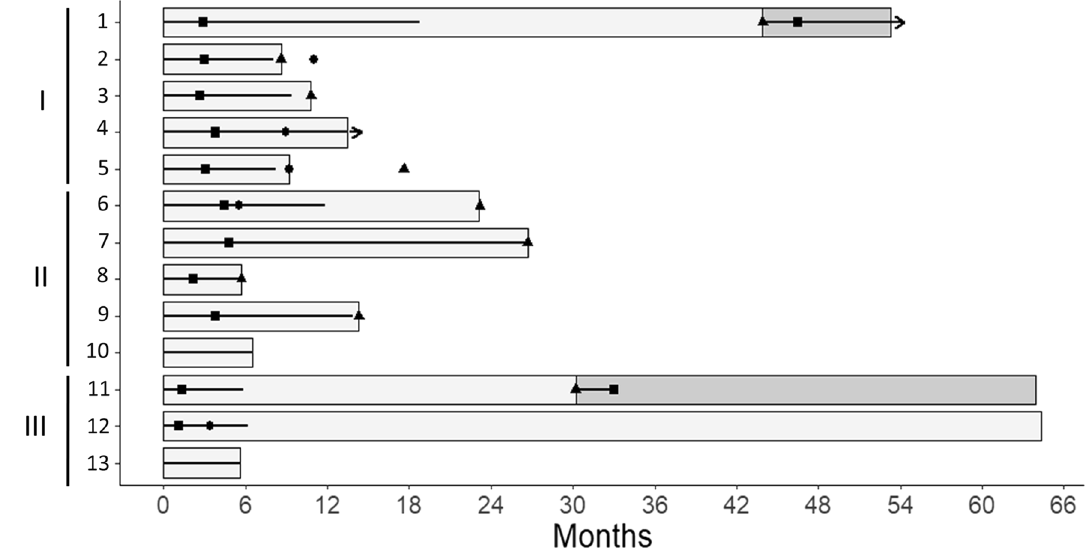
Figure 3. Chronological sequence of events in 13 patients treated with regimens comprising 5-fluorouracil, folinic acid, and high-dose pyridoxine in tandem. Types of tumor included colorectal adenocarcinoma (I), pancreas adenocarcinoma (II), and squamous cell carcinoma of the esophagus (III). Patients are numbered in the same order as in Tables 1, and 2, and in Fig. 2. Bars represent PFS times (light grey, and dark grey bars indicate 1st, and 2nd PFS times, respectively). Bold black lines within bars represent duration of treatment, and arrows indicate ongoing treatment. Solid squares indicate the time when response to therapy was recorded. Solid circles represent the time when surgery with eradication intent was performed. Solid triangles indicate the time when tumor progression was recorded in previous responders to